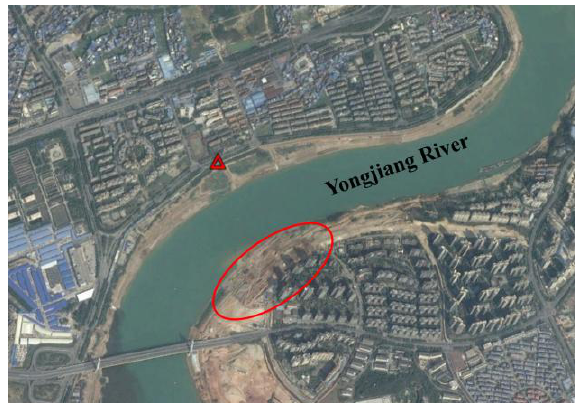
Figure 2. The location of LSP landslide. The red triangle denotes the location of the IBIS-L system, the red ellipse shown in the Figure 2 is the monitored